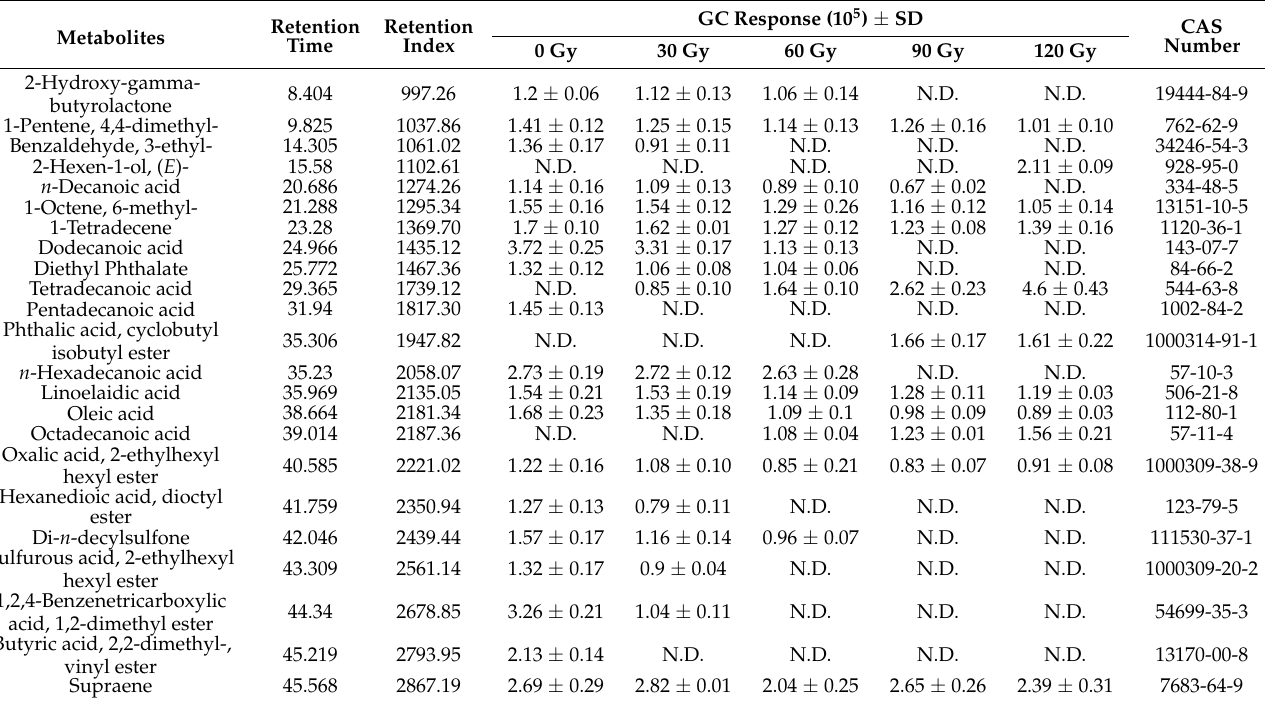
Table 1. Metabolites produced by B. dorsalis larvae treated with different irradiation